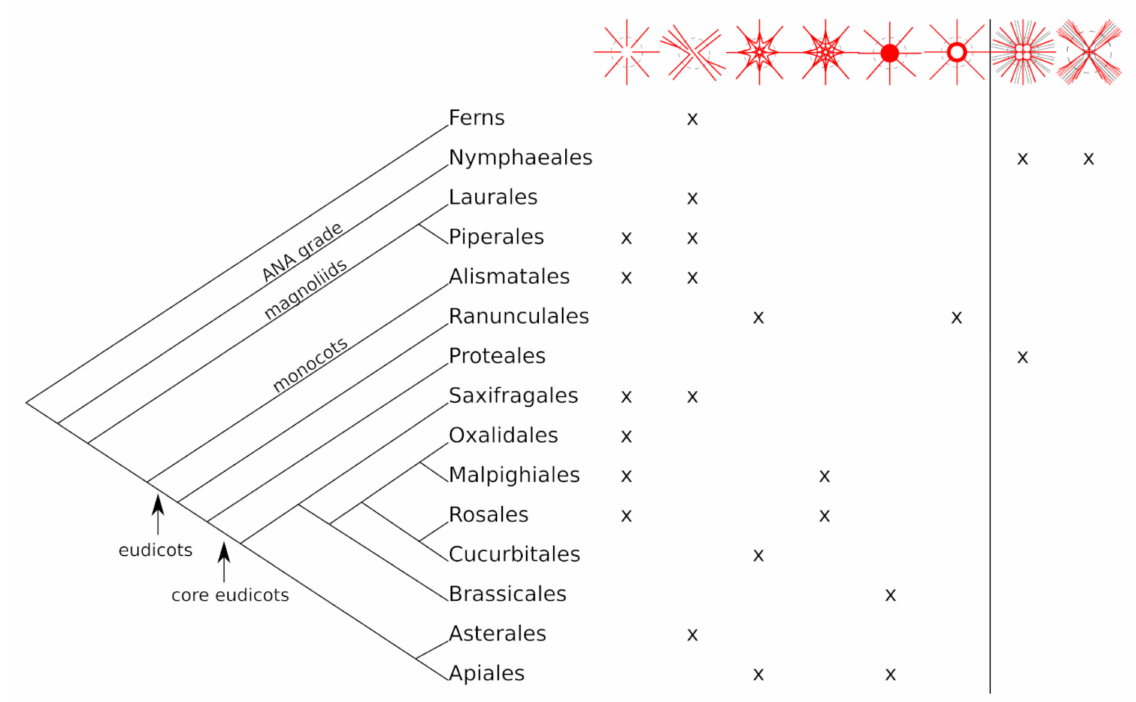
Figure 4. Distribution of the different strengthening structures in the petiole–lamina junction of peltate leaves within the plant kingdom. Strengthening structures (from left to right): unbranched, simple branching, net-like (intensities 1 and 2), knot-like, ring-like, radial (water plant), diffuse (water plant). The unbranched and simple branching type are the most common types found in six orders, followed by the net-like structure. All other structures only occur in one to two